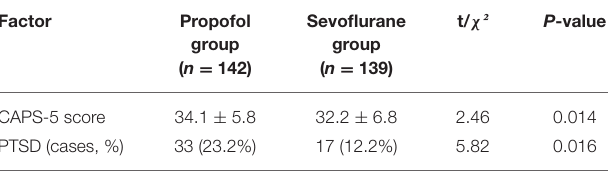
TABLE 1 | Demographic and surgery characteristics.